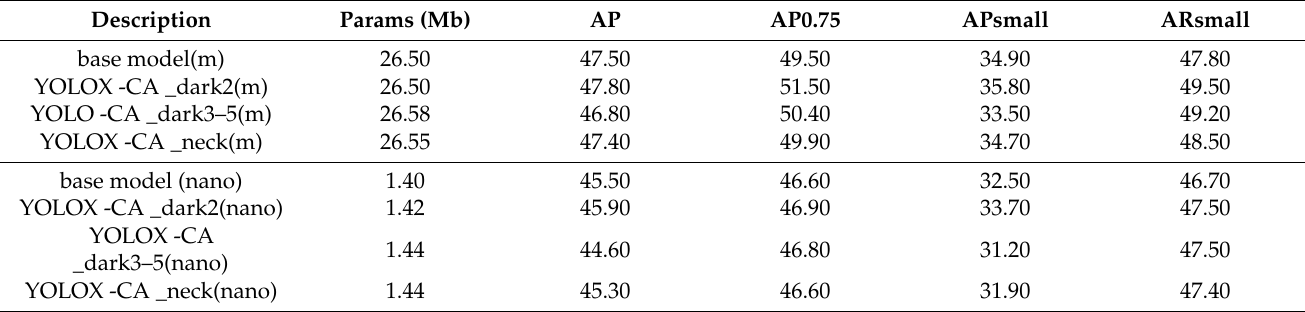
Table 9. The effect of the location and quantity of CA modules on the base model. The YOLOX model with the VariFocal loss function was used as the base model for this